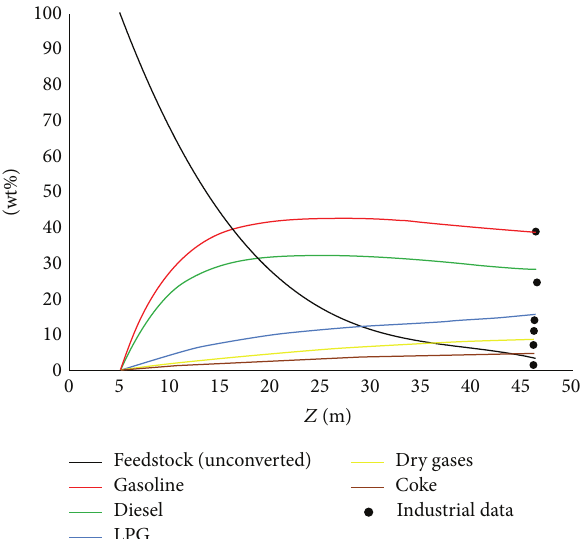
Figure 5: Model simulation results and industrial data.